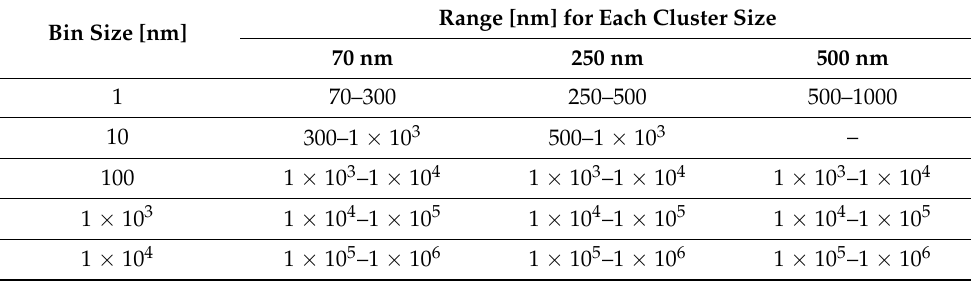
Table 2. Bin sizes used for the calculation of RDDs in water for each cluster size. Bin Size